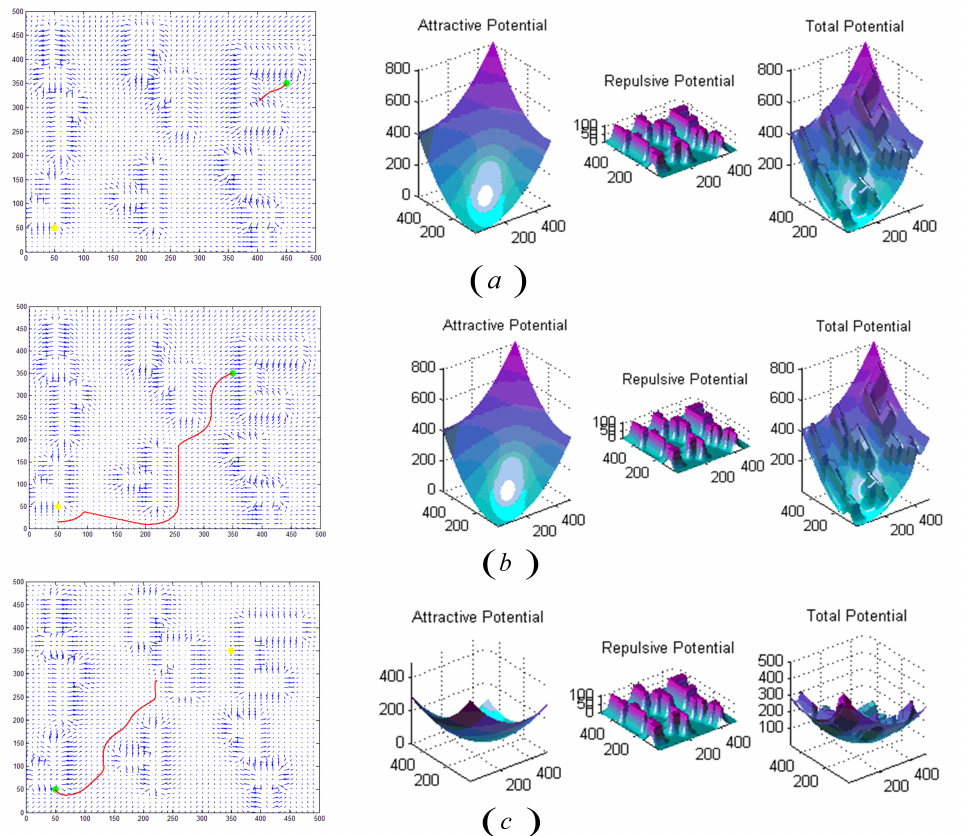
Figure 5. The path planning results of artificial potential field method on MATLAB: ( a ) Set the green dot in the upper right corner as the starting point and the yellow dot in the lower left corner as the end point, while the three-dimensional graphs of the attractive field, repulsive force field, and the total force field on the right side. Compared with ( a , b ) moved the starting point, and ( c ) exchanged the starting point and the end point. The result is shown in the